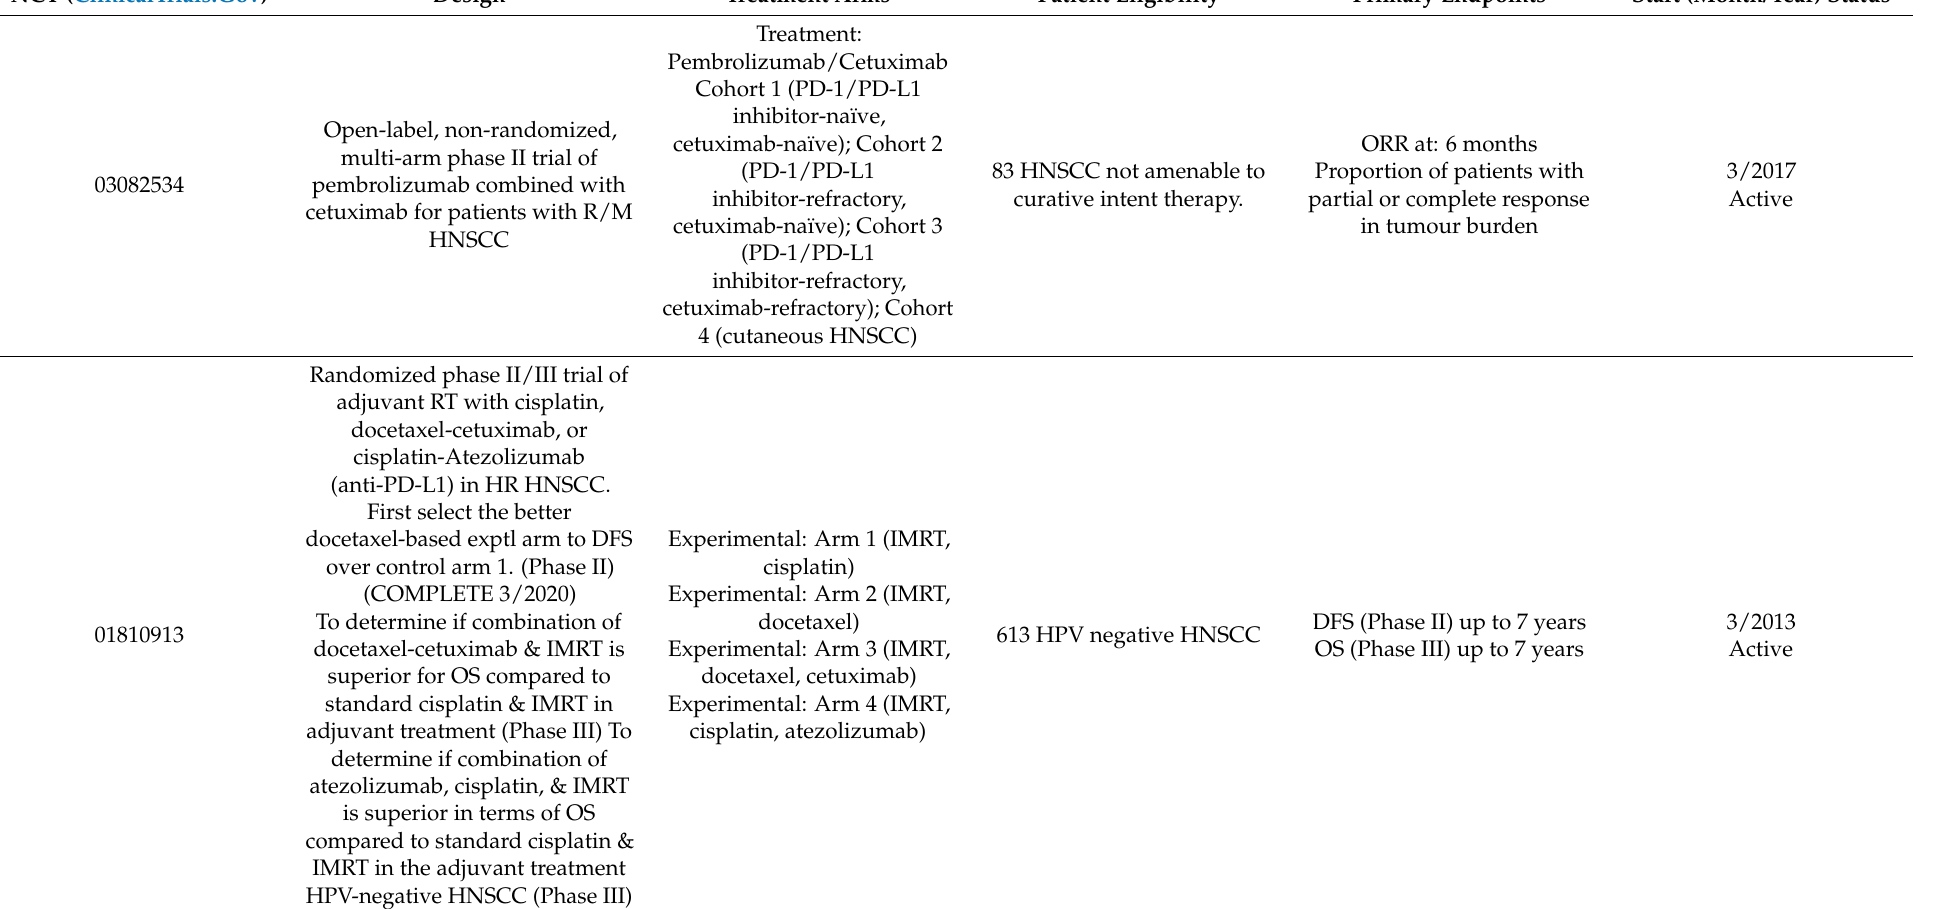
Table 3. Selected phase 2/3 clinical trials involving immune PD-1/PD-L1 pathway inhibitors in HNSCC(OPSCC). NCT